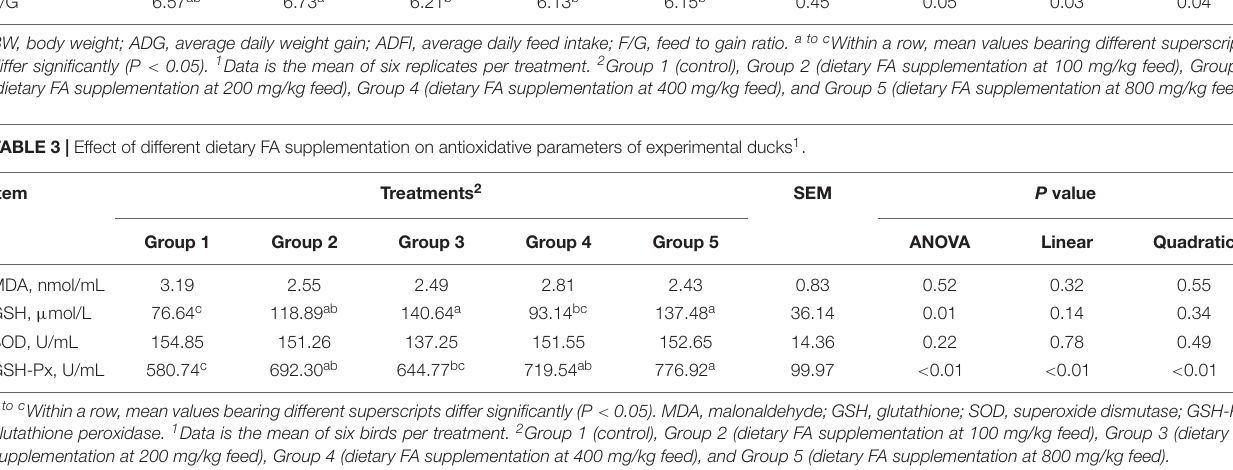
TABLE 4 | Effect of different dietary FA supplementation on immunological parameters of experimental ducks 1 .